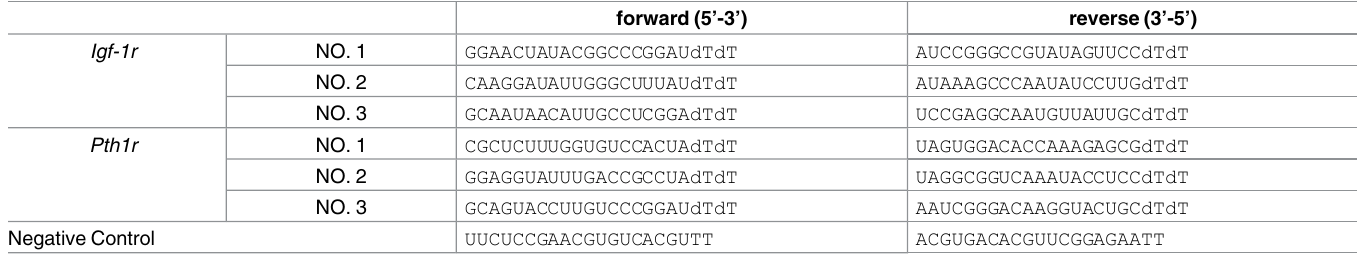
Table 1. Pth1r and Igf-1r siRNA